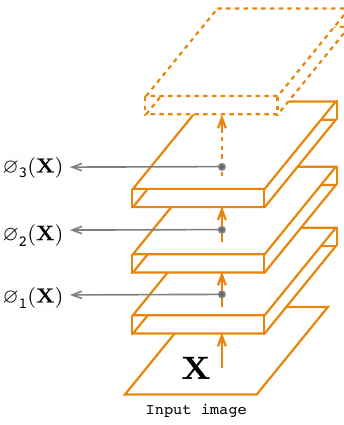
Figure 4. Deep feature